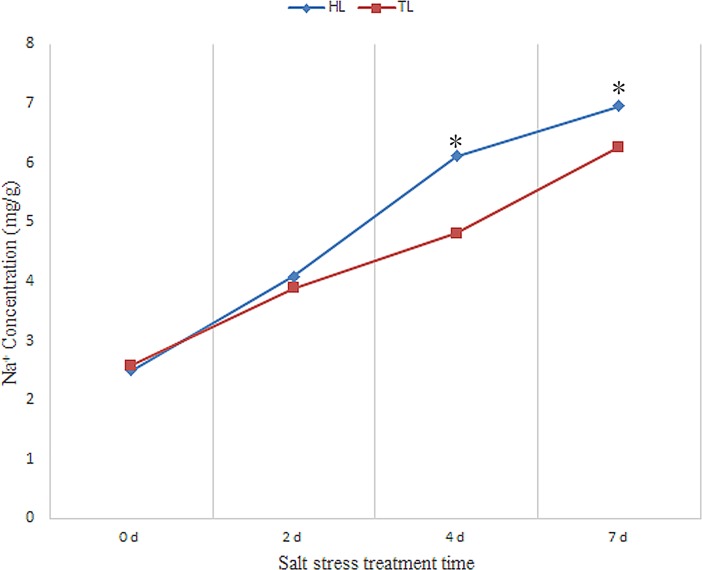
Na+ content in leaf tissue.The values are means (n = 5). The asterisk indicates a significant difference (p<0.05).